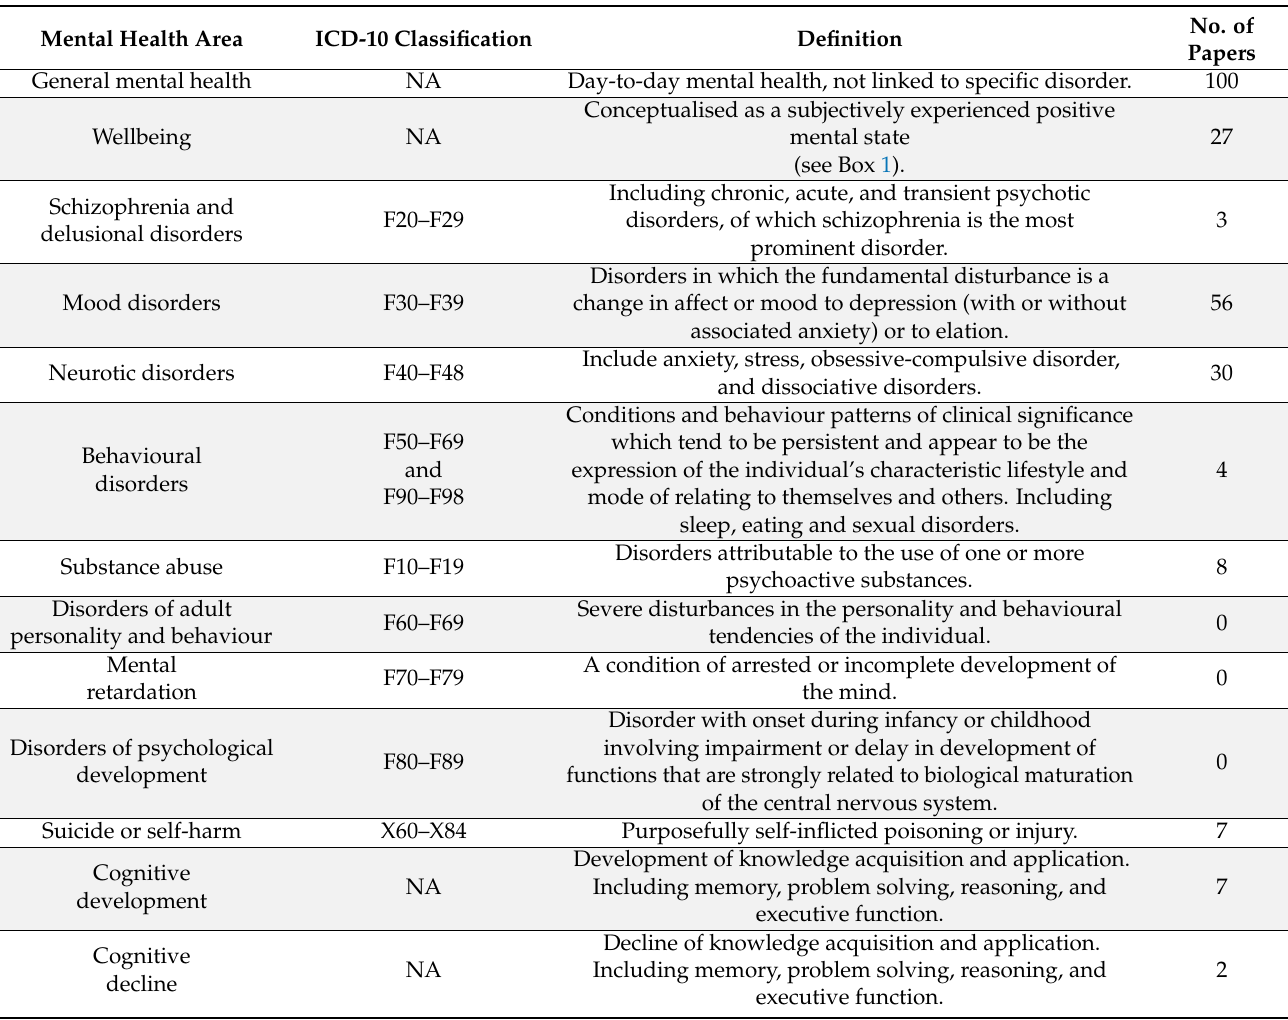
Table 4. Mental health research areas covered in our scoping review. Mental health disorders